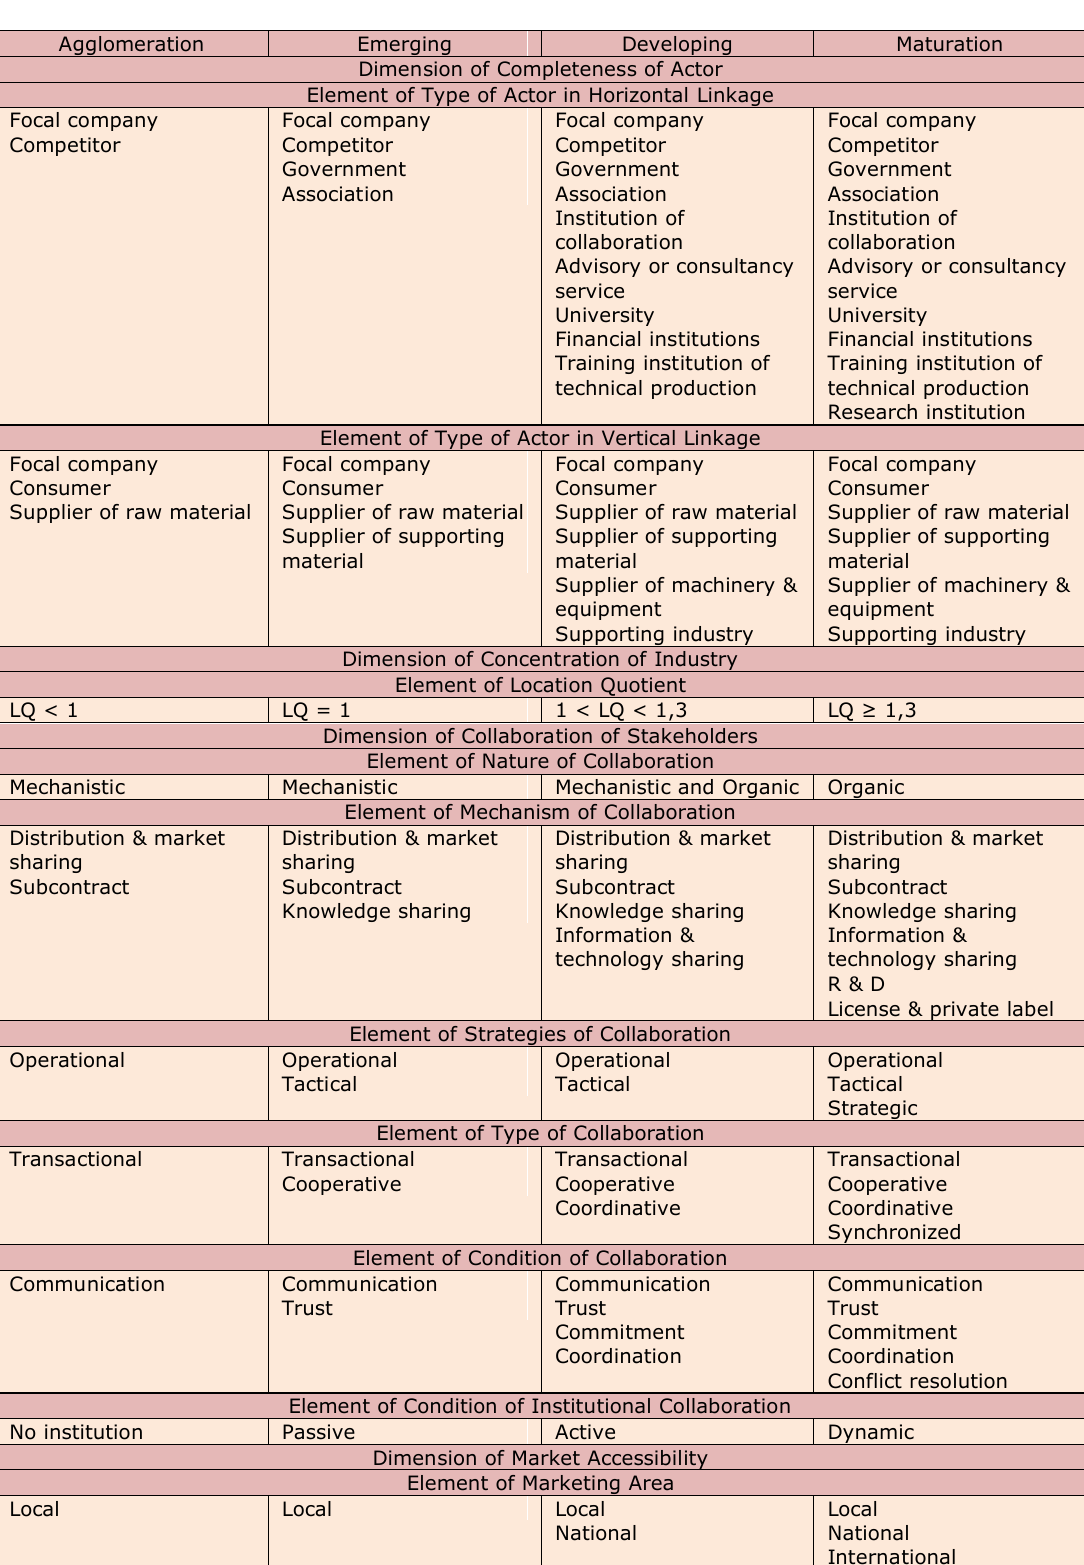
Table 8. Typology of Industrial Cluster Life Cycle The emerging phase is the beginning of collaboration. Three new actors join the cluster, namely the government, associations, and suppliers of supporting